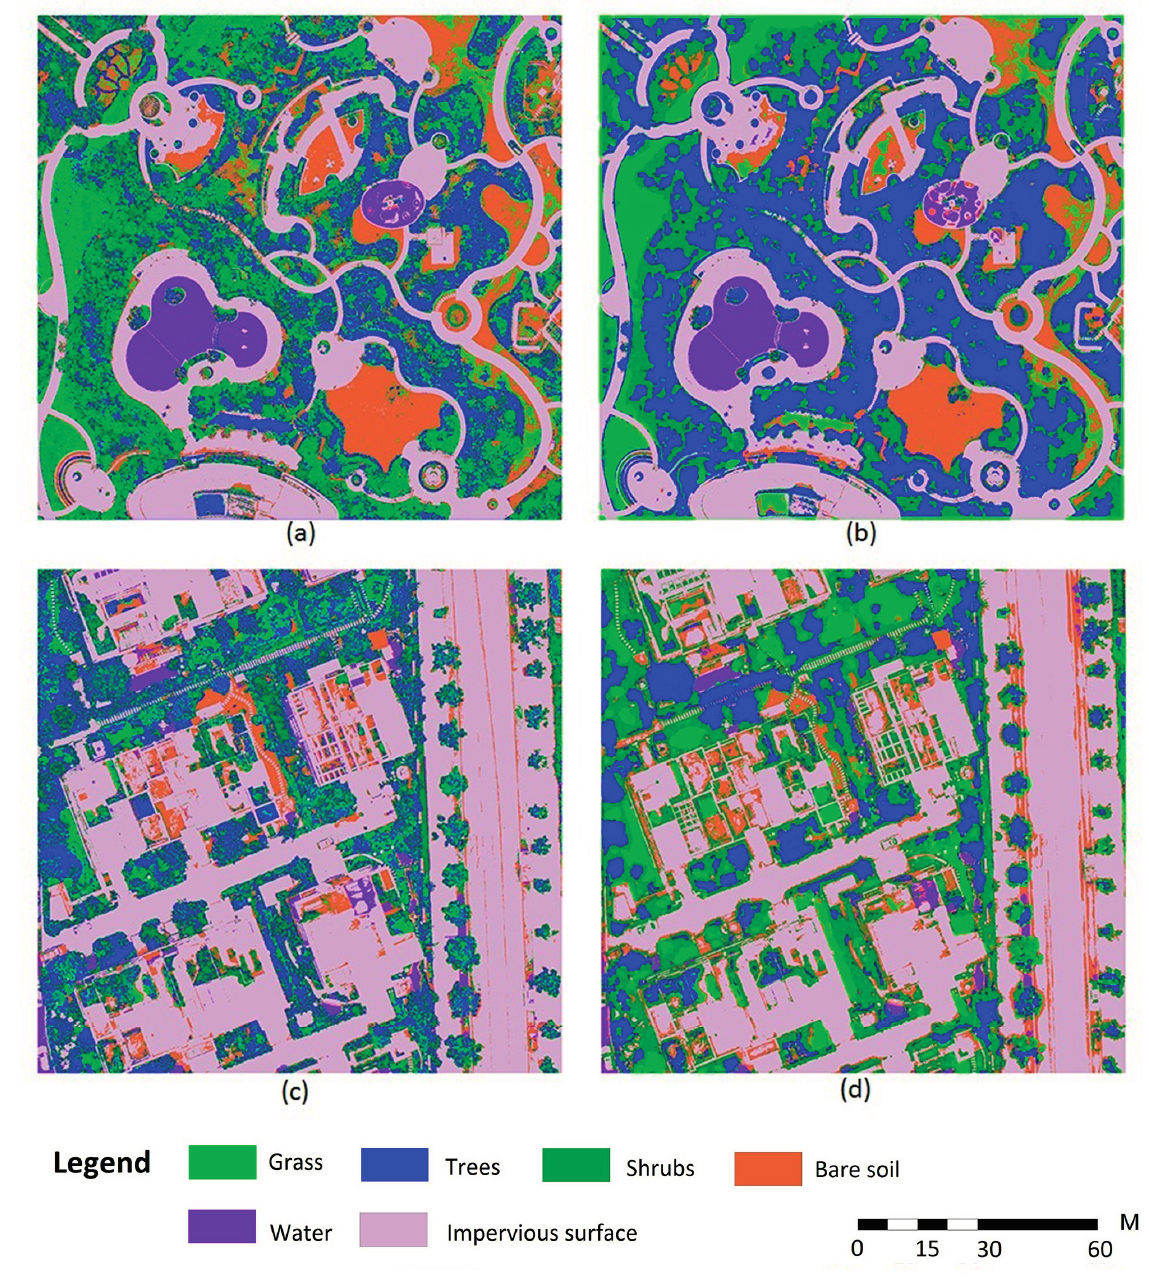
Figure 7. Classification results for RGB-only and RGB+GT31 using RF. ( a ) Image-A RGB-only; ( b ) Image-A RGB+GT31; ( c ) Image-B RGB-only; ( d ) Image-B